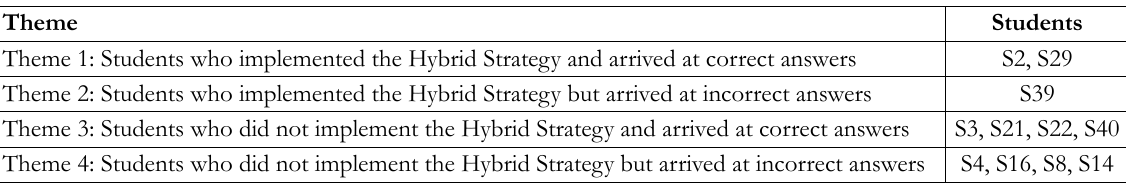
Table 5. Classification of themes for interview responses to Questions 3 and 4